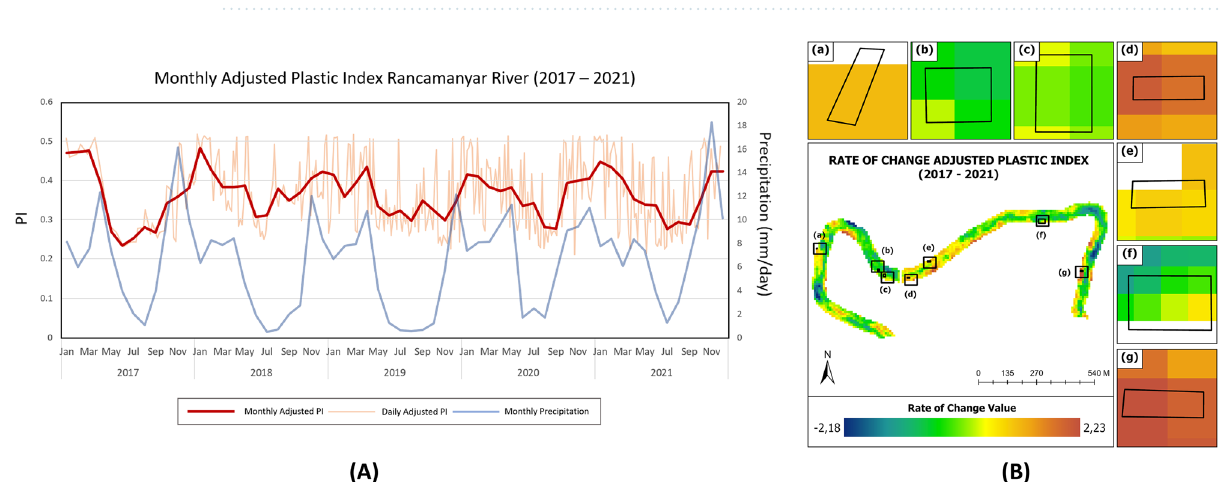
Figure 6. (A) Monthly and 5 days graph of the adjusted plastic index in all river study areas from 2017 to 2021 and (B) rate of change from the 2017–2021 adjusted plastic index data